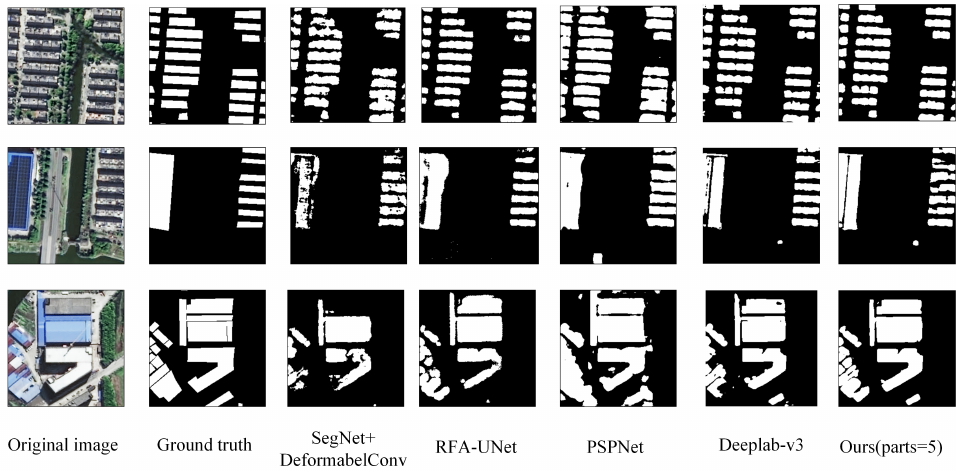
Figure 6. More visual results of different building extraction methods on the source